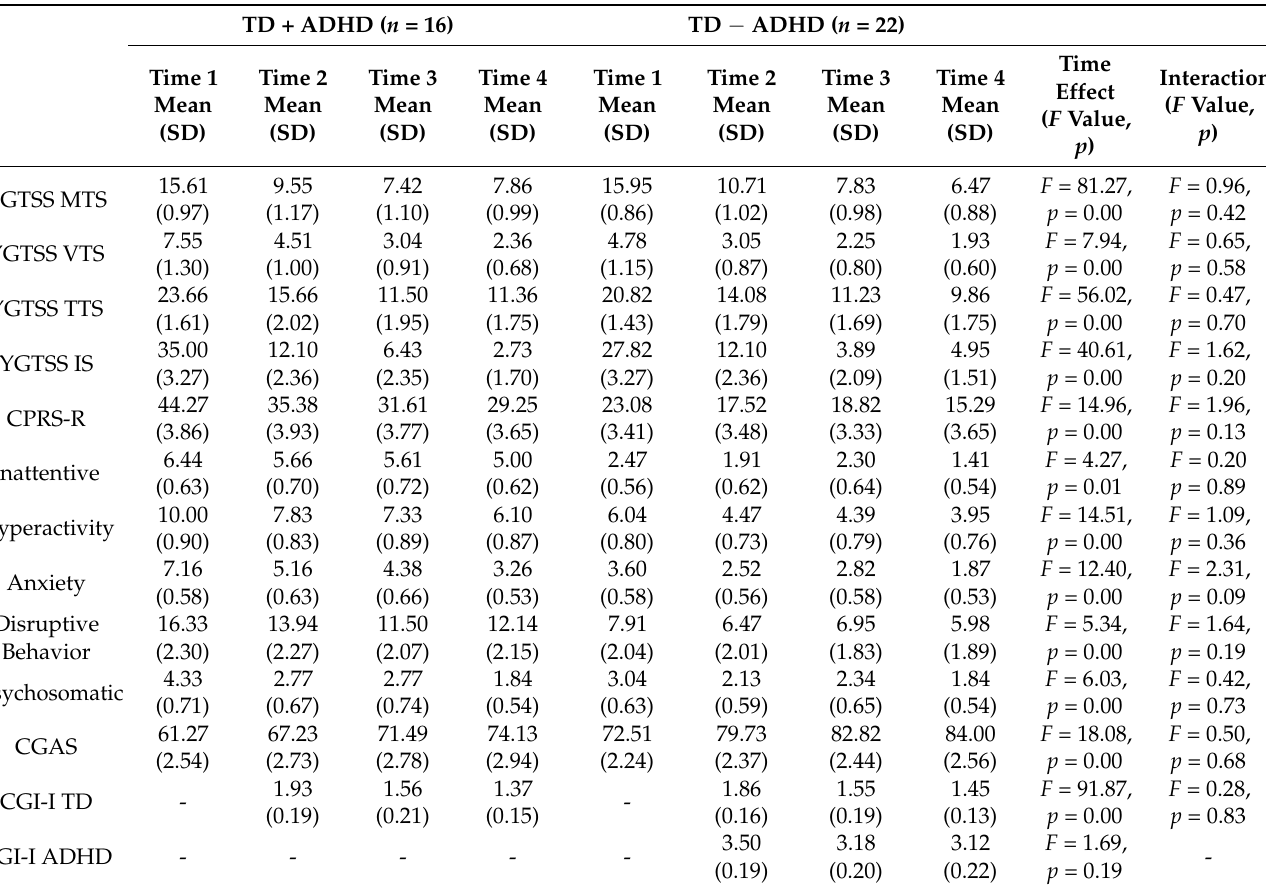
Table 2. Baseline (time 1), post-intervention (time 2) and 3-month (time 3) and 6-month (time 4) scores on measures of TD and